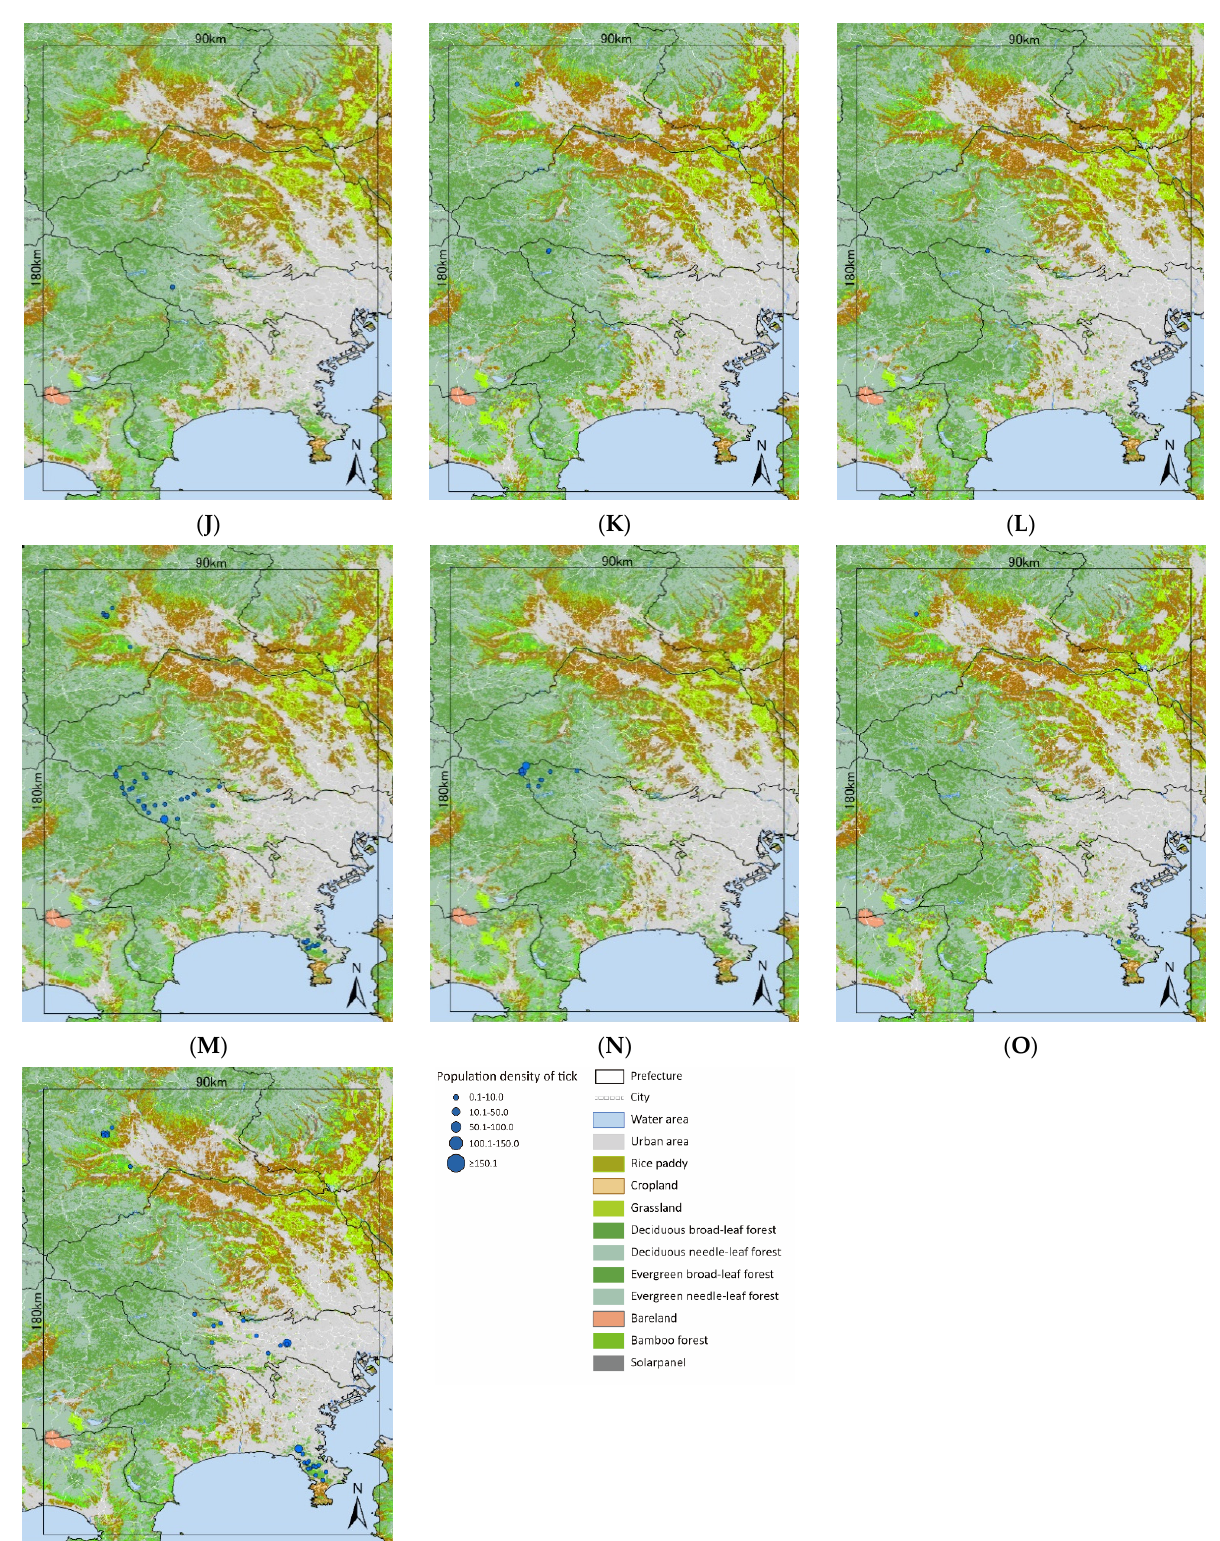
Figure 2. Tick collection sites for A. testudinarium ( A ), D. taiwanensis s.l. ( B ), H. flava ( C ), H. formosensis ( D ), H. hystricis ( E ), H. japonica ( F ), H. kitaokai ( G ), H. longicornis ( H ), H. megaspinosa ( I ), I. columnae ( J ), I. monospinosus ( K ), I. nipponensis ( L ), I. ovatus ( M ), I. persulcatus ( N ), I. tanuki ( O ), and I. turdus ( P ). The blue circle indicates where the species was collected, and the size of the circle indicates the population density of